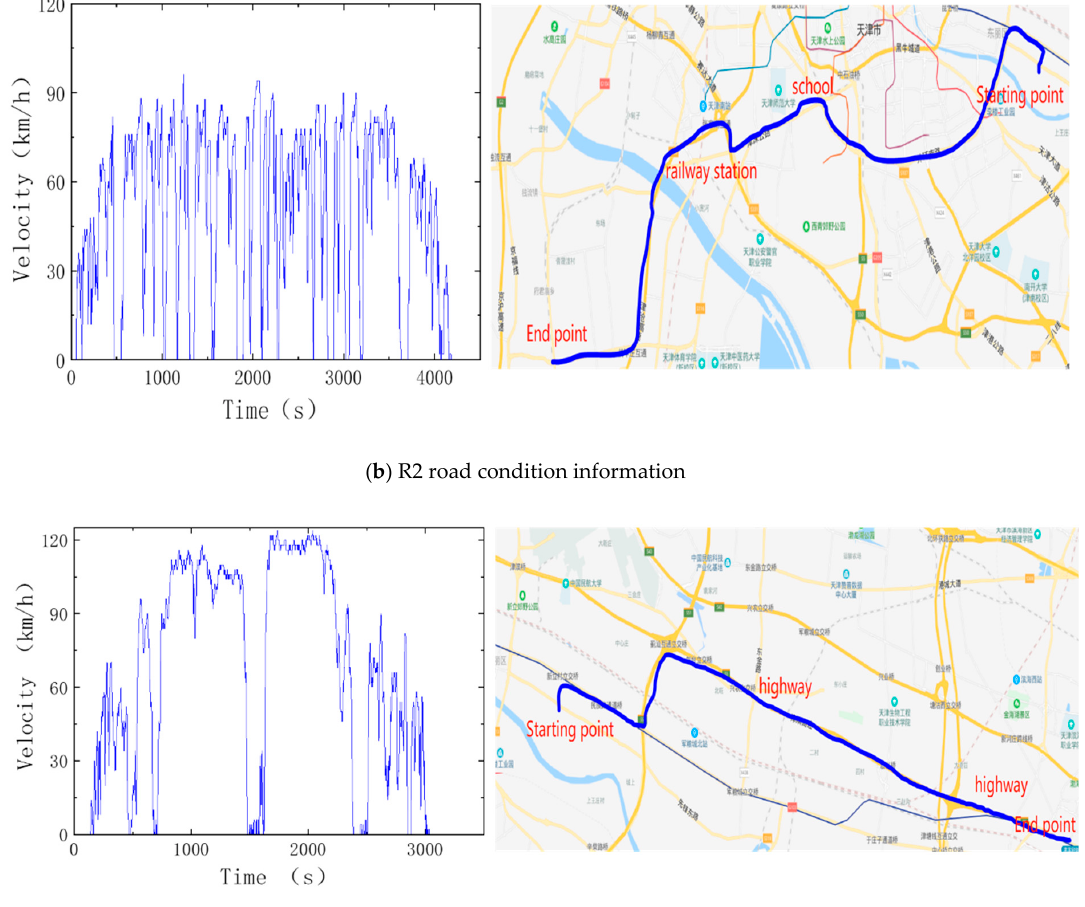
Figure 1. Curve of conditions of three real routes